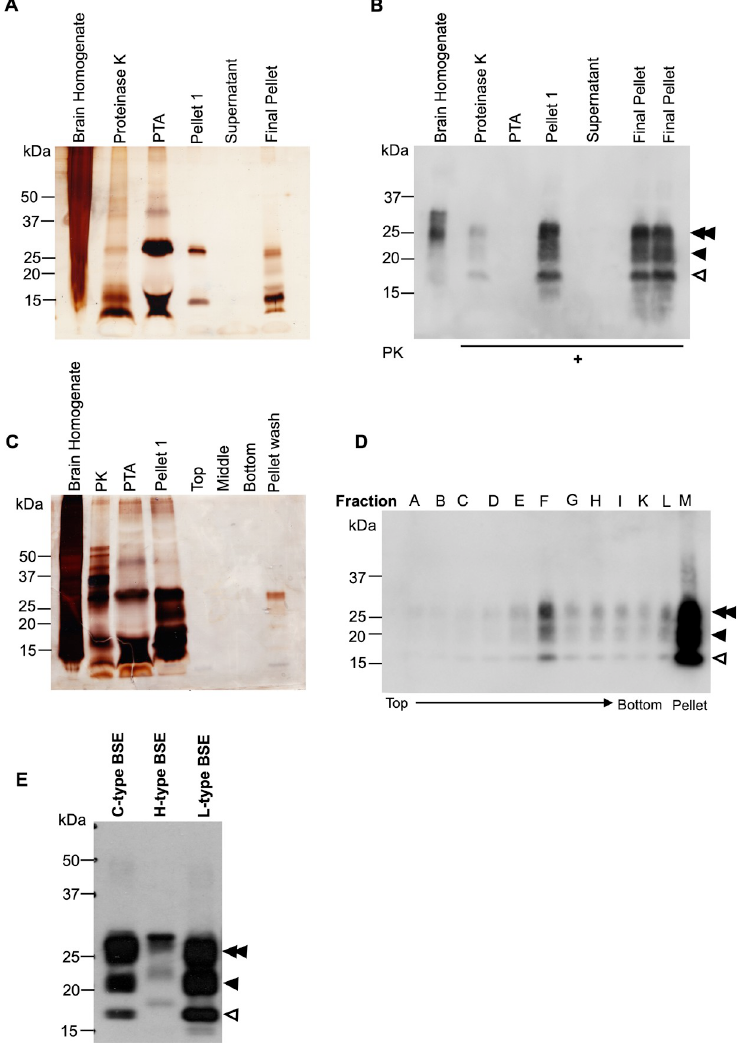
Fig 1. Purification of L-type BSE prions. ( A ) Silver stain SDS-PAGE gel of samples taken at different steps of the PTA purification. ( B ) Western blot of the L-type BSE prion purification samples using the D15.15 anti-prion monoclonal antibody. The PK-digested pellet 1 and the final pellet show the typical three bands of the bovine prion protein corresponding to di-, mono- and non-glycosylated forms (double arrowhead, single arrowhead, and open arrowhead, respectively). The two lanes labeled as final pellet represent the same sample. ( C ) Silver stain SDS-PAGE gel of samples from the sucrose step gradient centrifugation. The samples from the top, middle, bottom, and pellet wash fractions demonstrate the improved purity of the samples, even though the prion protein signal is relatively weak. Consistent with the Western blot analysis of the sucrose gradient fractions, the pellet-wash fraction shows stronger signals. ( D ) Western blot of the sucrose step gradient fractions. After ultracentrifugation through 40% and 80% sucrose, all fractions were separated based on their densities from top to bottom (A-L). The pellet-wash fraction (M) was obtained by washing the tube with 100 μ l of sucrose buffer. The Western blotting was developed using the D15.15 antibody. As expected, the middle fraction (F) shows a stronger signal compared to the top (40%) and the bottom fractions (80%). The pellet-wash fraction (M) also showed a high yield of L-type BSE prions. The di-, mono-, and non-glycosylated bands are again indicated by a double arrowhead, single arrowhead, and open arrowhead, respectively. ( E) Differences in migration patterns between L-type, C-type, and H-type BSE strains visualized in a Western blot of PK-treated brain homogenates of L-, C- and H-type BSE prions. Signals were detected using an anti-PrP monoclonal antibody, D15.15. In atypical BSE isolates, the electrophoretic migration of the unglycosylated PrP band is slightly higher (H-type) or lower (L-type) compared to classical BSE (C-type). The di-, mono-, and non-glycosylated bands are again indicated by a double arrowhead, single arrowhead, and open arrowhead,